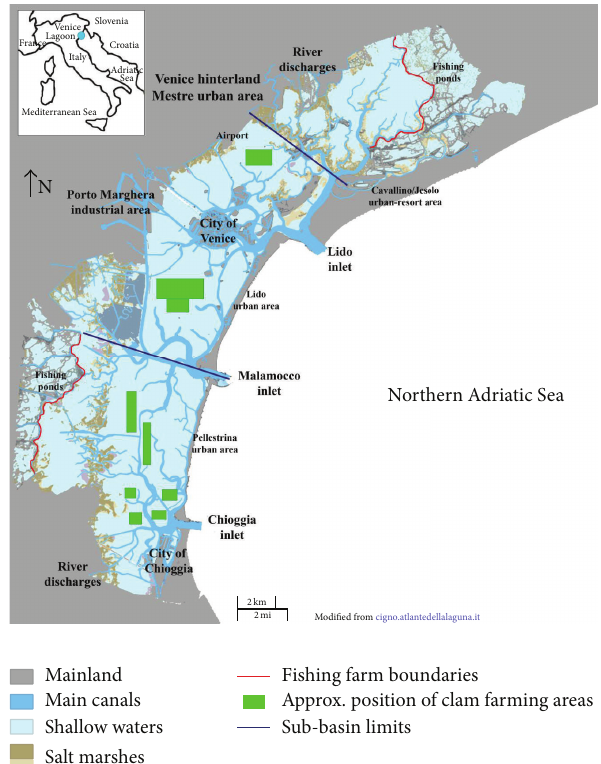
Figure 2: Study area: Venice Lagoon. Main anthropogenic pressures indicated in bold black. Solid blue lines separate lagoon into three morphological basins. Details of clam farming areas in